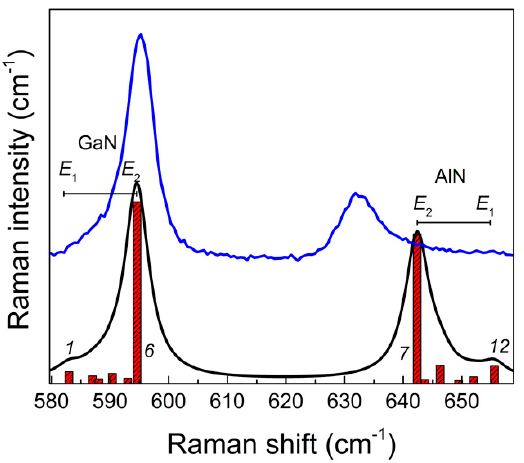
Figure 6. Raman frequencies and intensities of the E (TO) symmetry modes in the calculated spec- trum of the z ( xx ) z geometry for the (GaN) 6 /(AlN) 6 SL. The solid black line shows the averaged spectrum for the Lorentzian line shape and the line half-width of 3 cm − 1 . The blue line shows the experimental spectrum.